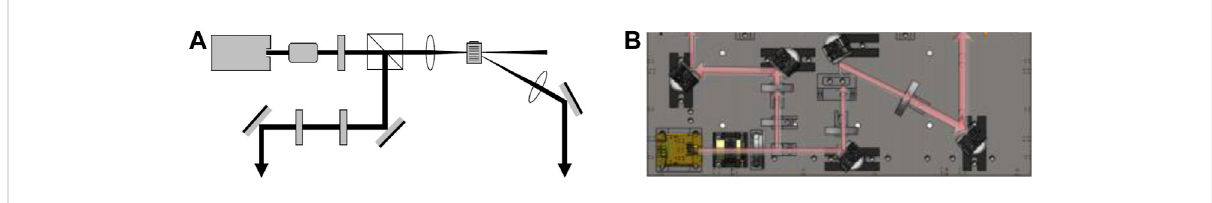
Optical bench of the OPCB. (A) The pumping laser and the probing laser are generated by one laser. (B) A photo of the optical